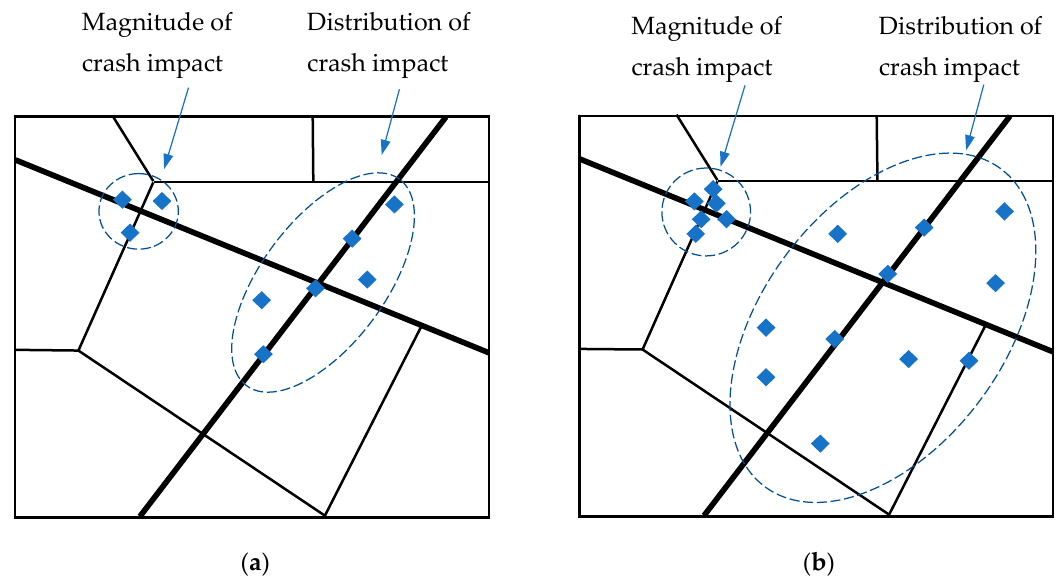
Figure 1. Spatial resilience elements via crash pattern display. ( a ) Pre-weather; ( b ) post-weather.